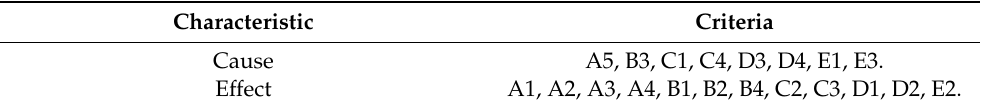
Table 3. Cause–effect characteristics of